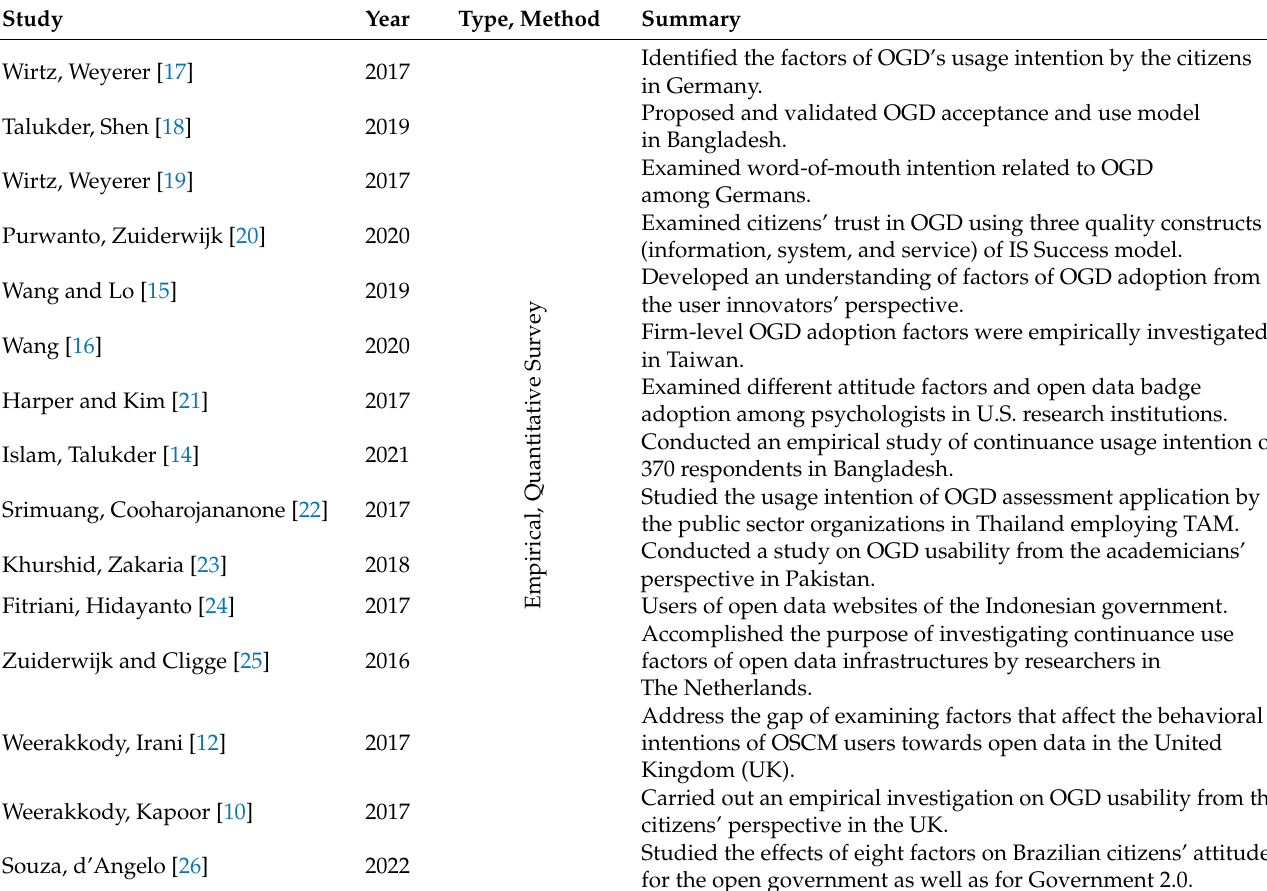
Table 1. A brief overview of studies on OGD intention to